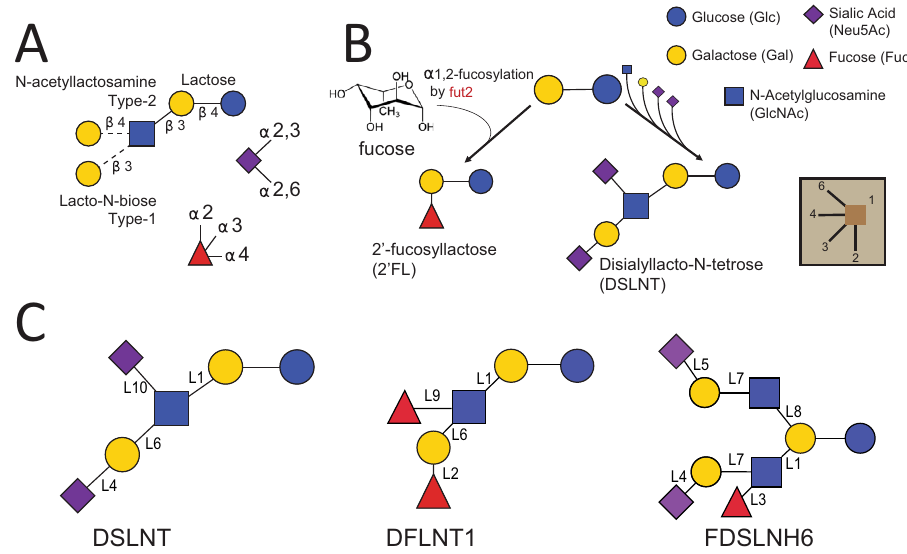
Fig. 1 HMO blueprint and synthesis. A HMOs are built from a combination of the fi ve monosaccharides D -glucose (Glc, blue circle), D -galactose (Gal, yellow circle), N -acetyl-glucosamine (GlcNac, blue square), L -fucose (Fuc, red triangle), and sialic acid ( N -acetyl-neuraminic acid (NeuAc), purple diamond). Lactose (Gal- β -1,4-Glc) forms the reducing end and can be elongated with several Lacto-N-biose or N -acetyllactosamine repeat units (Gal- β -1,3/4-GlcNAc). Lactose or the polylactosamine backbone can be fucosylated with α -1,2-, α -1,3-, or α -1,4- linkages or sialylated in α -2,3- or α -2,6- linkages 2 . B Small HMOs can be fucosylated to make 2 ′ FL while larger HMOs can be synthesized by the extension of the core lactose with N -acetylactosamine (type-I) or lacto- N - biose (type-II) and subsequent decoration of the extended core with sialic acid to make more complex HMOs, such as DSLNT. C Three HMOs in this study: DSLNT, isomer 1 of DFLNT, isomer 6 of FDSLNH; isomer structures represent predictions from this study (see Methods, Supplementary Fig. 5). Each monosaccharide-linking glycosidic bond is labeled (L1, L2, … L10) according to the linkage reactions listed in Table